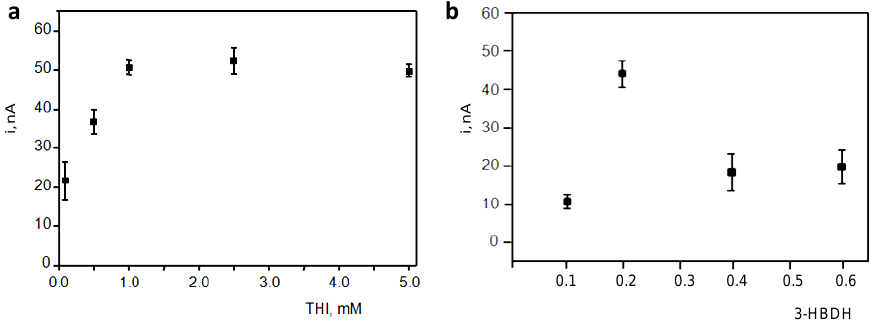
Figure 3. Effect of the THI and enzyme loadings on the amperometric responses measured with THI/rGO/SPCE ( a ) and 3-HBDH/THI/rGO/SPCE biosensors ( b ).